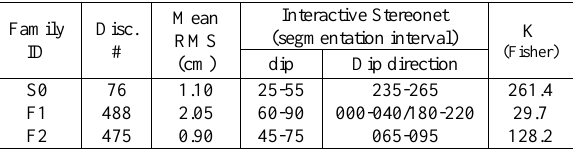
Table 4. Discontinuity families characteristics for the Saulges cliff